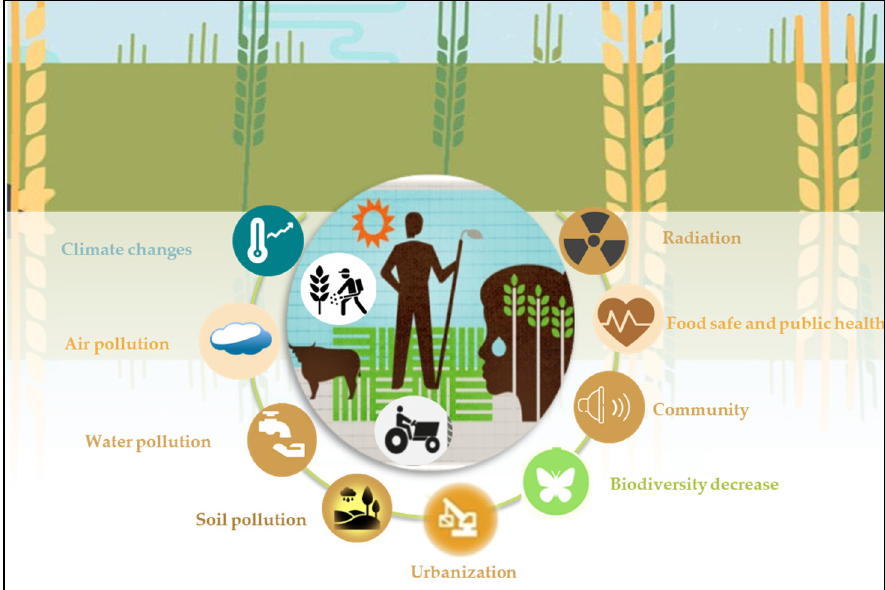
Figure 2. Agriculture’s impact on the environment.